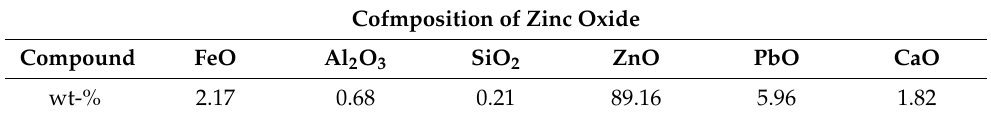
Table 2. Chemical composition of the zinc oxide.